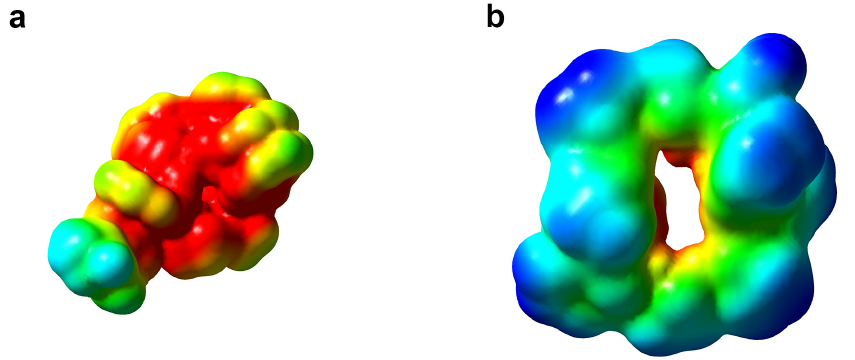
Figure 3. The ESP surfaces of gramicidin D ( a ) and gramicidin S ( b ). ESP potential is presented from a value of − 20 (red) to − 10 (blue). Table 1. Intermolecular interactions between SARS ‐ CoV ‐ 2 PL pro and gramicidin D/gramicidin S.